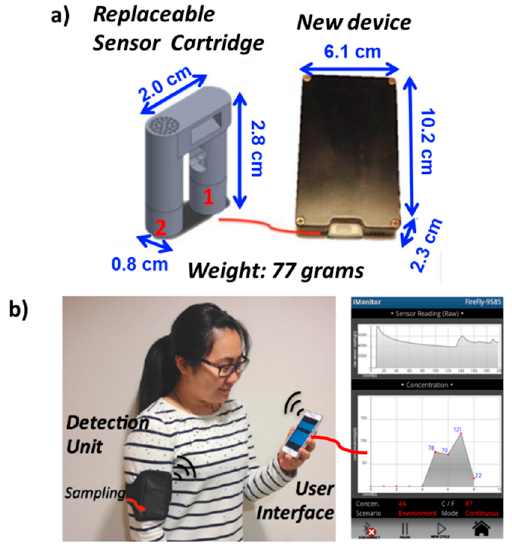
Figure 1. ( a ) Device dimension and weight; ( b ) Pictures of sensor components and user interface on a smart phone.